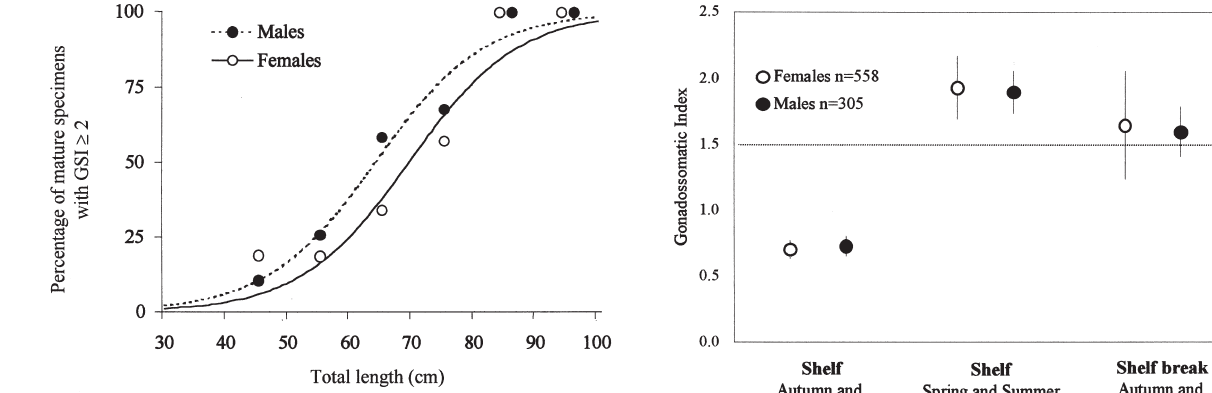
F IG . 4. – Percentages of males (n=169) and females (n=379) with I curves fit for the determination of first maturity total length (TL of Trichiurus lepturus in southern Brazil.